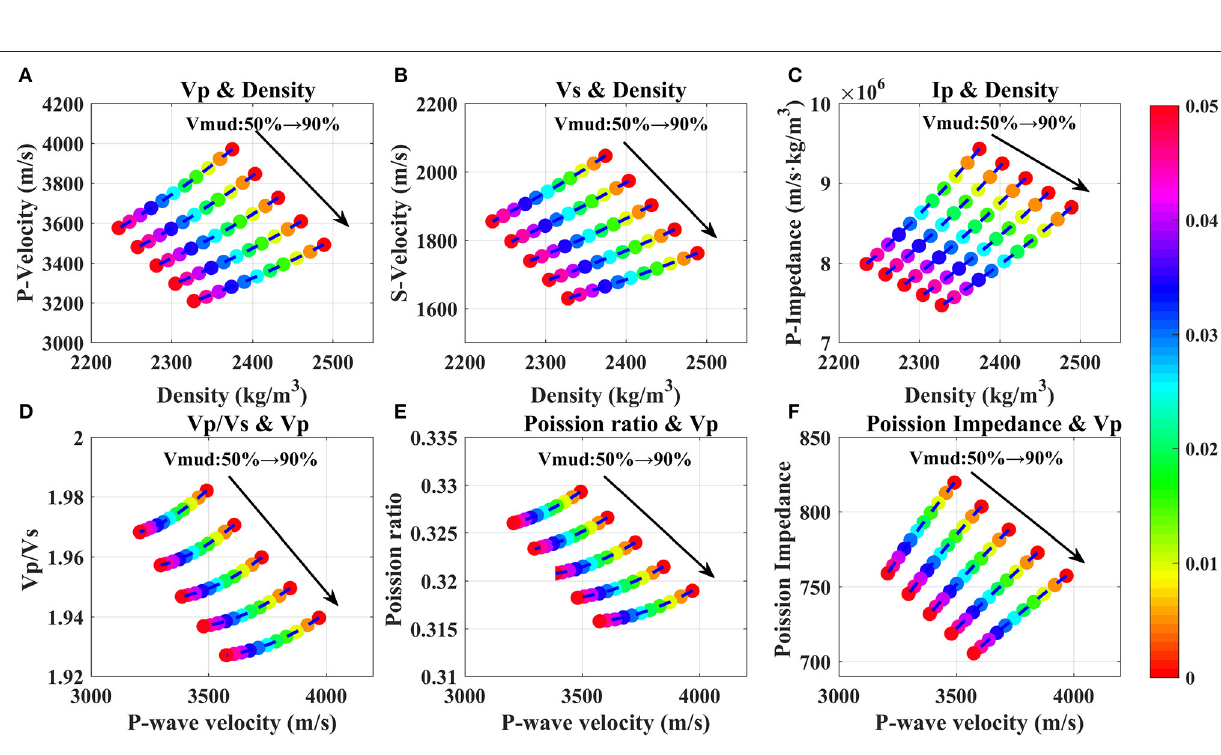
Frontiers in Earth Science |